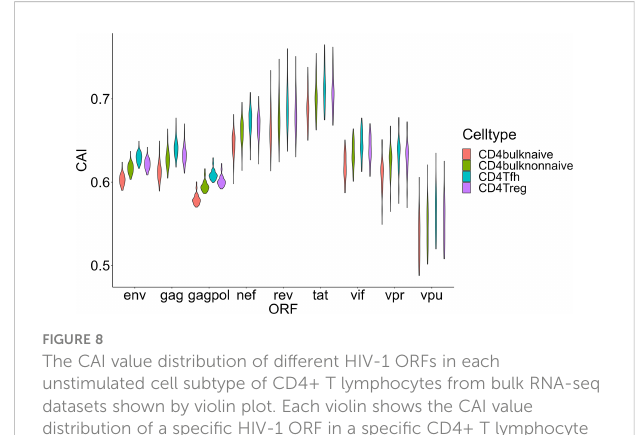
FIGURE 8 The CAI value distribution of different HIV-1 ORFs in each unstimulated cell subtype of CD4+ T lymphocytes from bulk RNA-seq datasets shown by violin plot. Each violin shows the CAI value distribution of a speci fi c HIV-1 ORF in a speci fi c CD4+ T lymphocyte